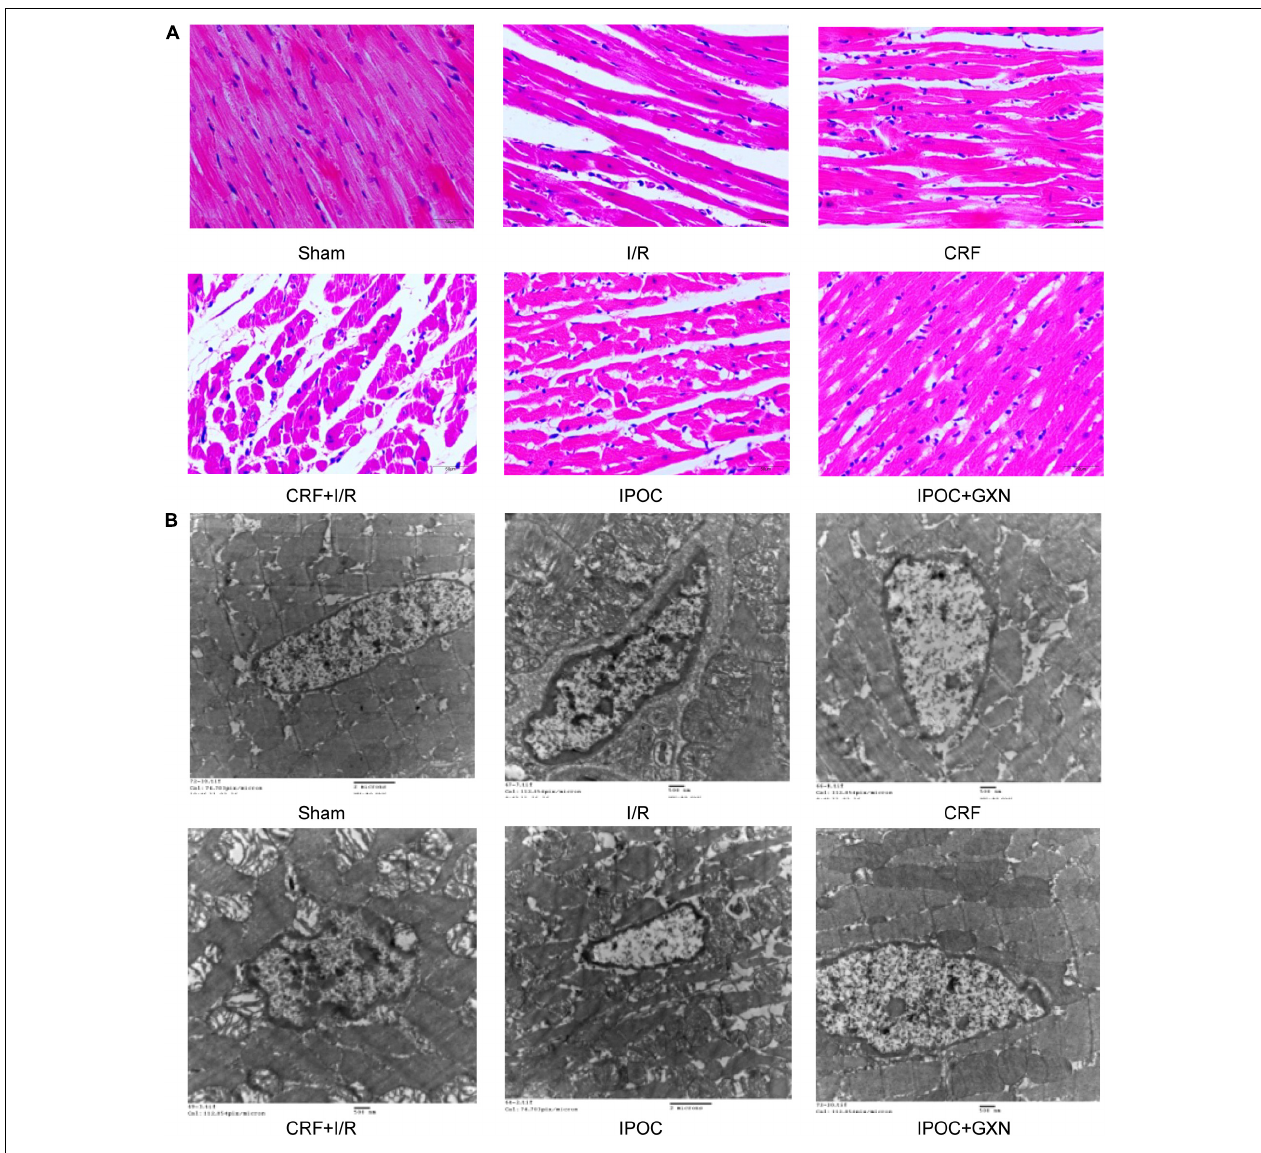
FIGURE 5 | Morphology and ultrastructure of the myocardium. (A) HE staining; (B) Electron microscopical images of